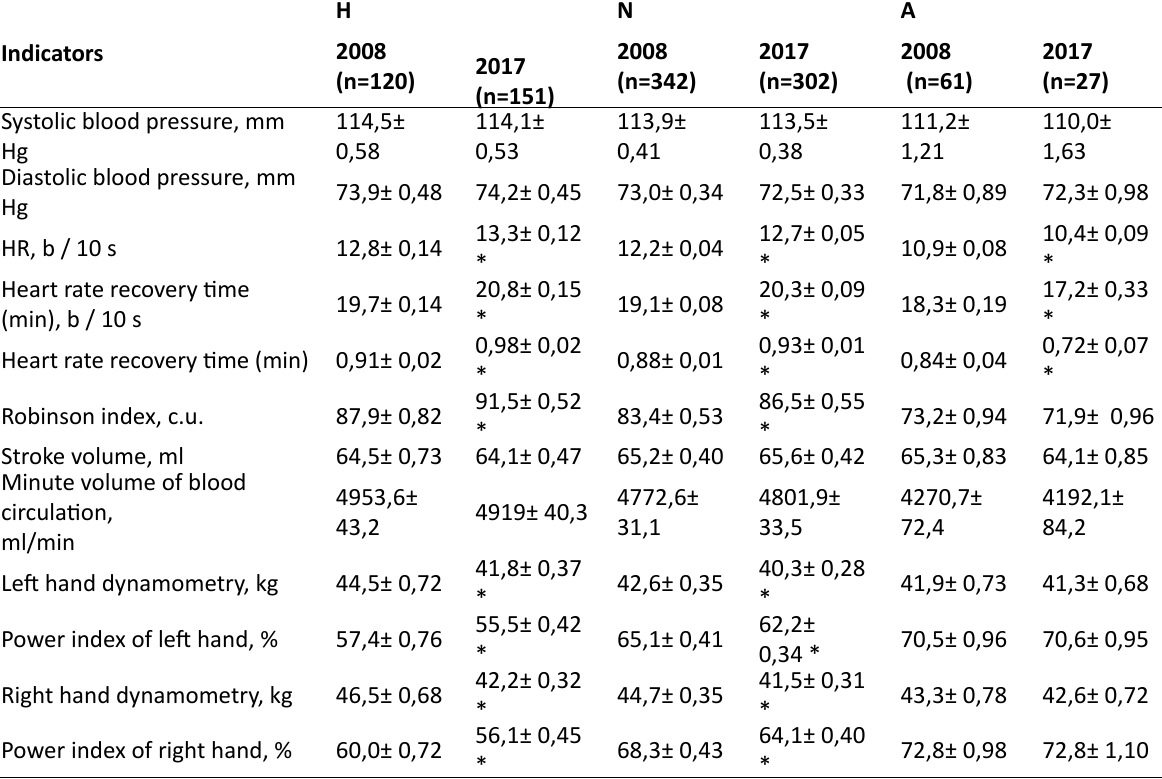
Table 2. Functional characteristics of young men with different body types examined in 2008 and 2017. (M ± SD)